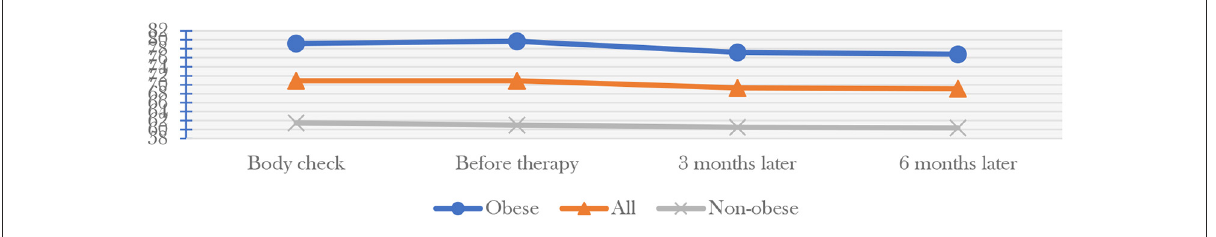
FIGURE3 Weight Effect on participants after the forest therapy activity.